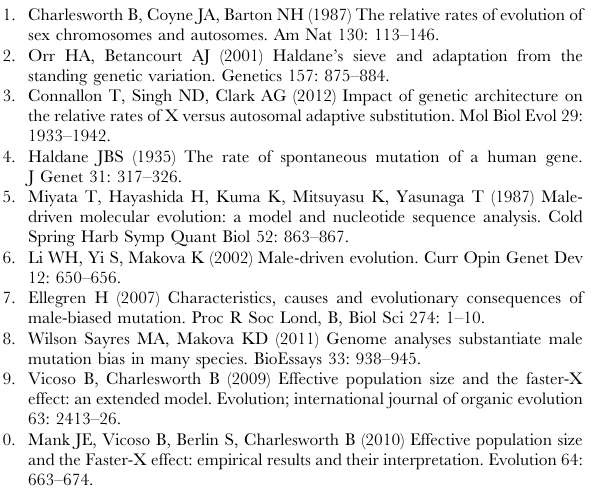
with the 95% CI of the correlation. The dashed line indicates the null expectation of no correlation. Figure S14 Genes in repressive chromatin are more narrowly expressed. Genes were divided into those that are in transcrip- tionally active and repressive chromatin using data from two cell lines: BG3 and S2. (A) Expression breadth ( t ) was compared between genes in active and repressive chromatin using a Mann- Whitney U test (***** P v 0 : 000005 ). Larger values of t indicate narrower expression breadth. (B) Genes were additionally divided into those that are broadly and narrowly expressed, and the counts of genes in each expression breadth and chromatin state are plotted for data collected in BG3 cells (S2 data are available in Figure 7). Fisher’s exact test was used to determine if there is a significantly non-random distribution of genes in the four classes. Figure S15 The faster-X effect is limited to narrowly expressed genes in transcriptionally repressive chromatin, with chromatin environment measured in BG3 cells. This figure is the same as Figure 8 except chromatin state was measured in BG3 cells. Figure S16 The faster-X effect is limited to narrowly expressed genes in transcriptionally repressive chromatin, with chromatin environment measured in BG3 cells. This figure is the same as Figure 8 and Figure S15 except that genes with the lowest 5% expression levels were excluded. Figure S17 Expression breadth, chromatin environment, and X-linkage. The expression breadth ( t ) of genes in transcriptionally active and repressive chromatin on the X chromosome and autosomes is plotted. Larger values of t indicate narrower expression breadth. Chromatin state was inferred in BG3 and S2 cells. Significant differences between X-linked and autosomal genes in the same chromatin context are indicated by asterisks (* P v 0 : 05 , *** P v 0 : 0005 , **** P v 0 : 00005 ). (A) Median expression breadth across the entire genome is indicated by a dashed line. (B) Genes were additionally divided into narrowly and broadly expressed. Figure S18 No faster-X effect for genes narrowly expressed in female reproductive tissues. Boxplots show the pairwise divergence in expression